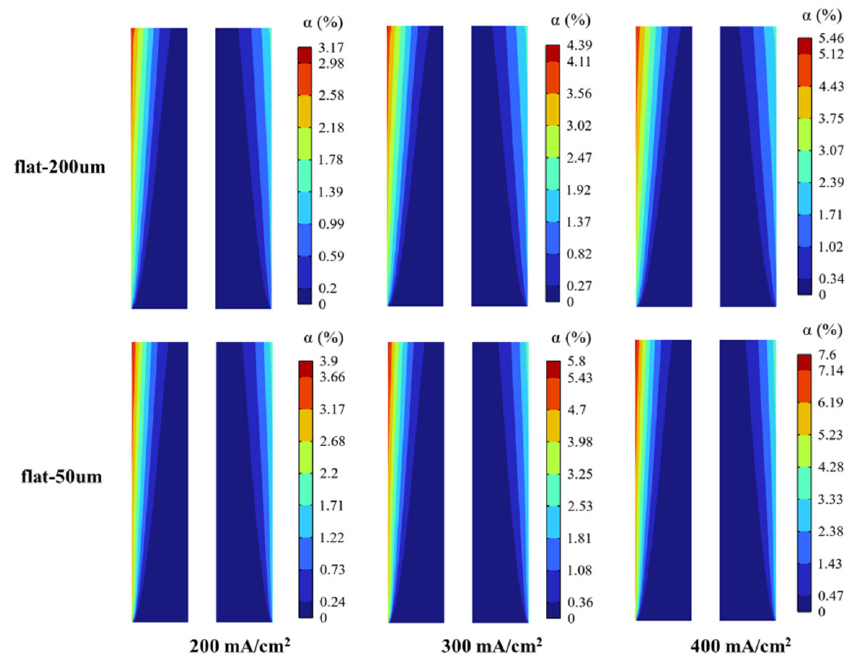
Figure 4. Gas void fraction distribution corresponds to two bubble diameters under different current densities.